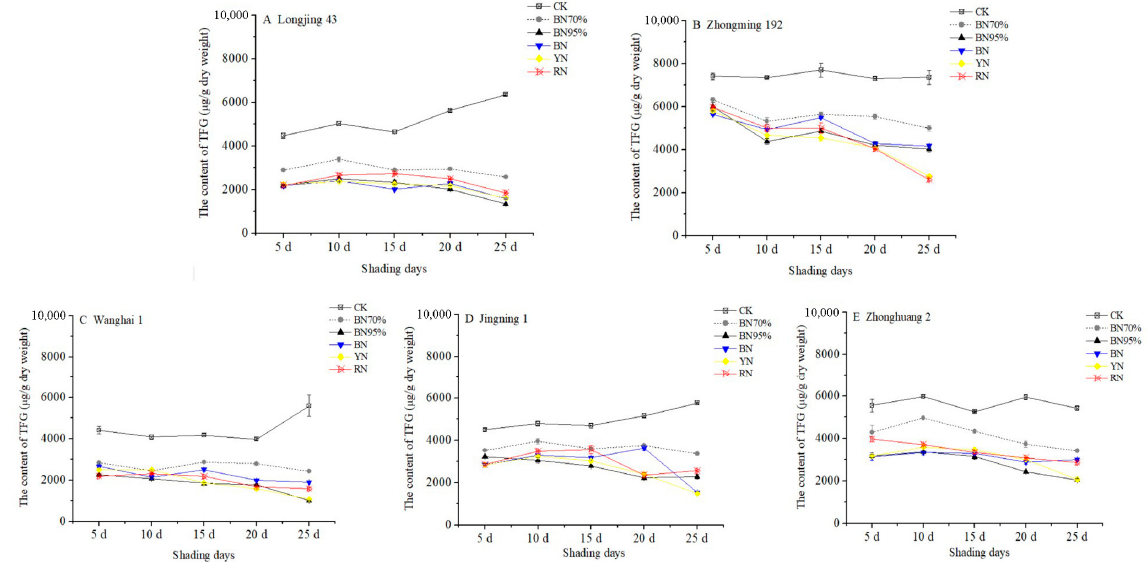
Figure 3. The impacts of shade treatments on the contents of total flavonol glycosides in the young shoots of different tea cultivars. TFG: total flavonol glycosides. Significantly different results are shown in Table S2.